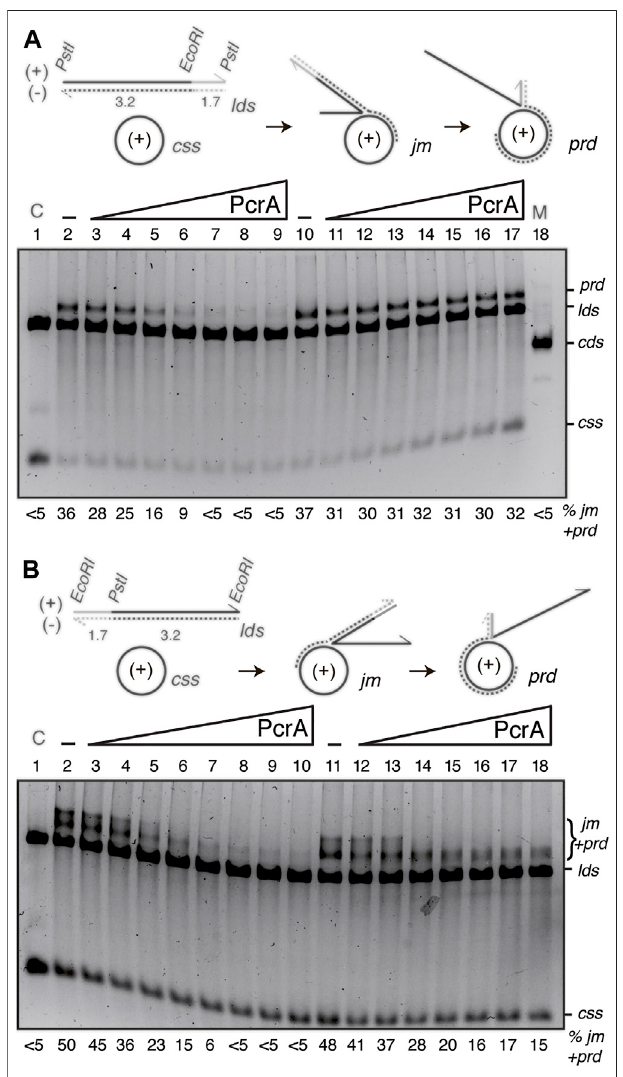
FIGURE 6 | PcrA inhibits RecA-mediated DSE independently of the polarityofDSE. (A,B) Cartoonsillustrating thethree-strand exchange reaction between circular 3199 nt ssDNA ( css , +) and the 4374 bp lds substrate with homology onthe(-)strand restrictedtothe3 ′ -end( (A) , Pst Isubstrate)or to the5 ′ -end( (B) , Eco RIsubstrate). The expected prd fi nal products ofRecA- mediated DSE are illustrated. The relevant restriction sites are indicated. The relative lengths of homology (denoted in black) and heterology (denoted in grey)areindicated.( (A,B) ,lanes2 – 9)SsbA(300 nM)andRecO(100 nM)were pre-incubated with cssDNA (10 μ M in nt) (for 5 min at 37 ° C). Then, increasing PcrA (6 – 400 nM) and fi xed RecA (800 nM), lds Pst I (A) or Eco RI (B) (10 μ M in bp) and ATP (5 mM) concentrations were added, and the reaction was incubated (60 min at 37 ° C). ( (A,B) , lanes 10[11] – 18[19]) SsbA (300 nM) and RecO (100 nM), RecA and lds Pst I (A) or Eco RI (B) were pre-incubated with cssDNA (10 μ M in nt) (for 20 min at 37 ° C). Then, increasing PcrA (6 – 400 nM) and fi xed ATP (5 mM) concentrations were added, and the reaction was incubated for 60 min at 37 ° C. The products of the reactions were processed as described in Figure 5 . The positions of the bands and substrates are described in Figure 5 . The % of jm s and products ( nc and prd ) are indicated and expressed asthepercentage oftotalsubstrate added.Theresultsarethe average value obtained from more than three independent experiments and representative gels are shown here (the results given stand within a 5% standard